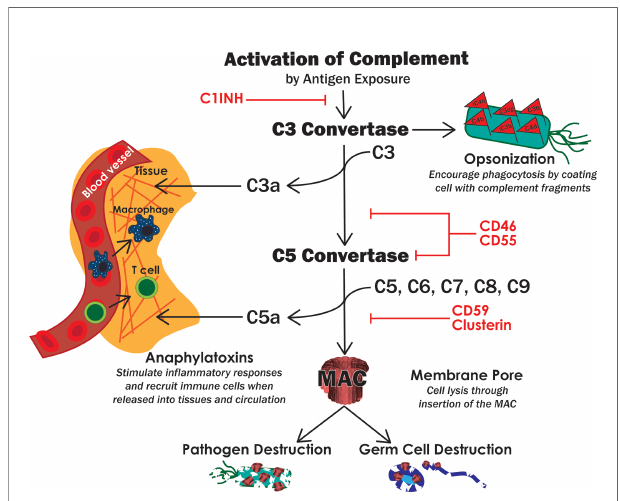
FIGURE 3 | The complement system. Activation of complement leads to the formation of two convertases, which then lead to opsonization of target cells, secretion of proin fl ammatory anaphylatoxins and insertion of the MAC pore. These functions of complement work together to destroy pathogens but can also destroy host cells if not properly regulated. Red text indicates known complement inhibitors expressed by Sertoli cells.